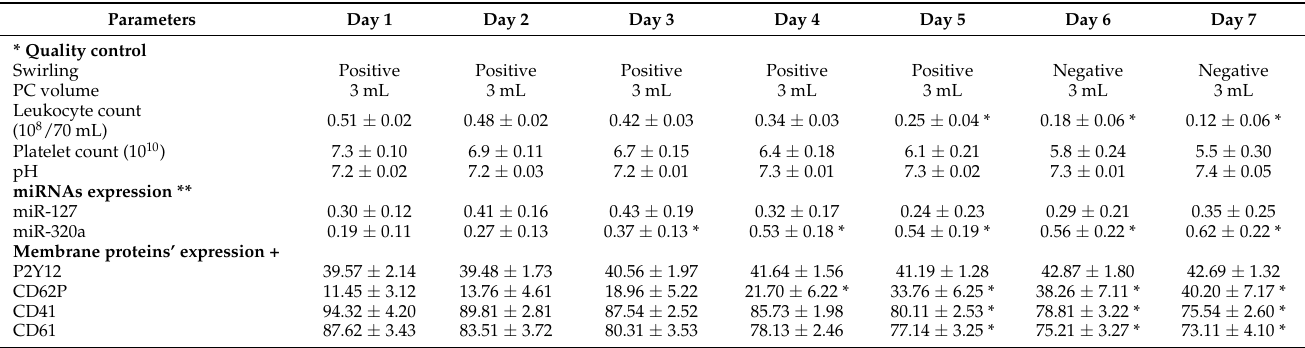
Table 1. Parameters evaluated in platelet concentrates.